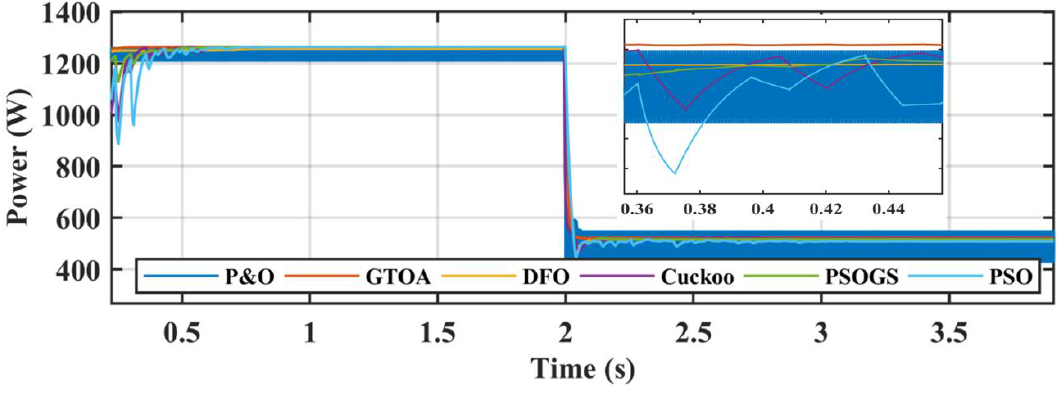
Figure 10. Zoomed-in comparison of power of GTOA.